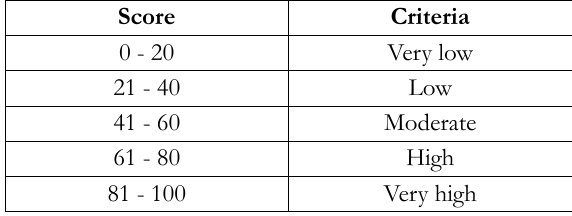
Table 4. The Criteria of Literacy Project